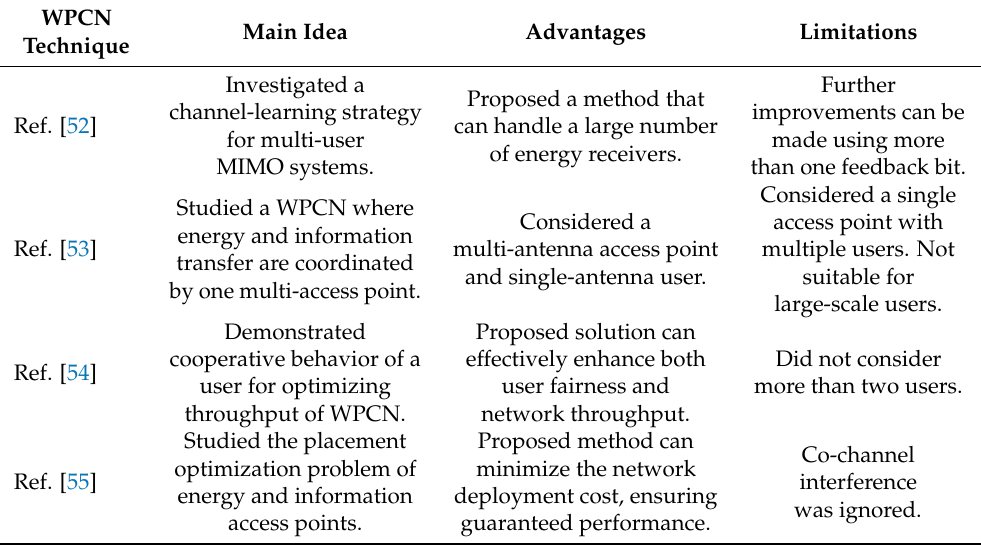
Table 9. Comparison of existing WPCN techniques in terms of the main idea, advantages, and limitations.